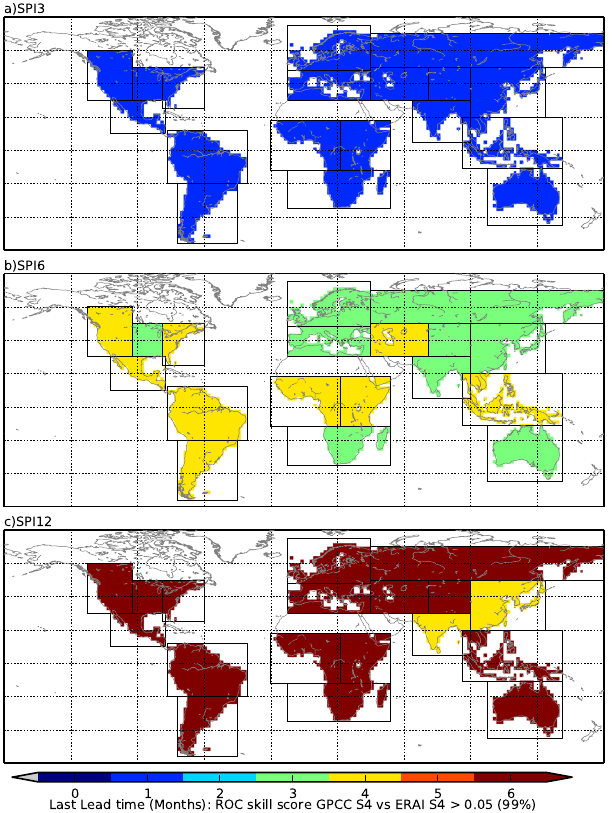
Figure 2. Last forecast lead time (months) where the ROC skill score of GPCC S4 (using ERAI S4 as reference forecasts) is higher than 0.05 with 95% confidence and the ROC of GPCC S4 is higher than 0 with 95% confidence. Seasonal forecasts of the (a) SPI-3, (b) SPI-6, and (c) SPI-12. The forecasts are verified in each region for the calendar month presented in Table 1.